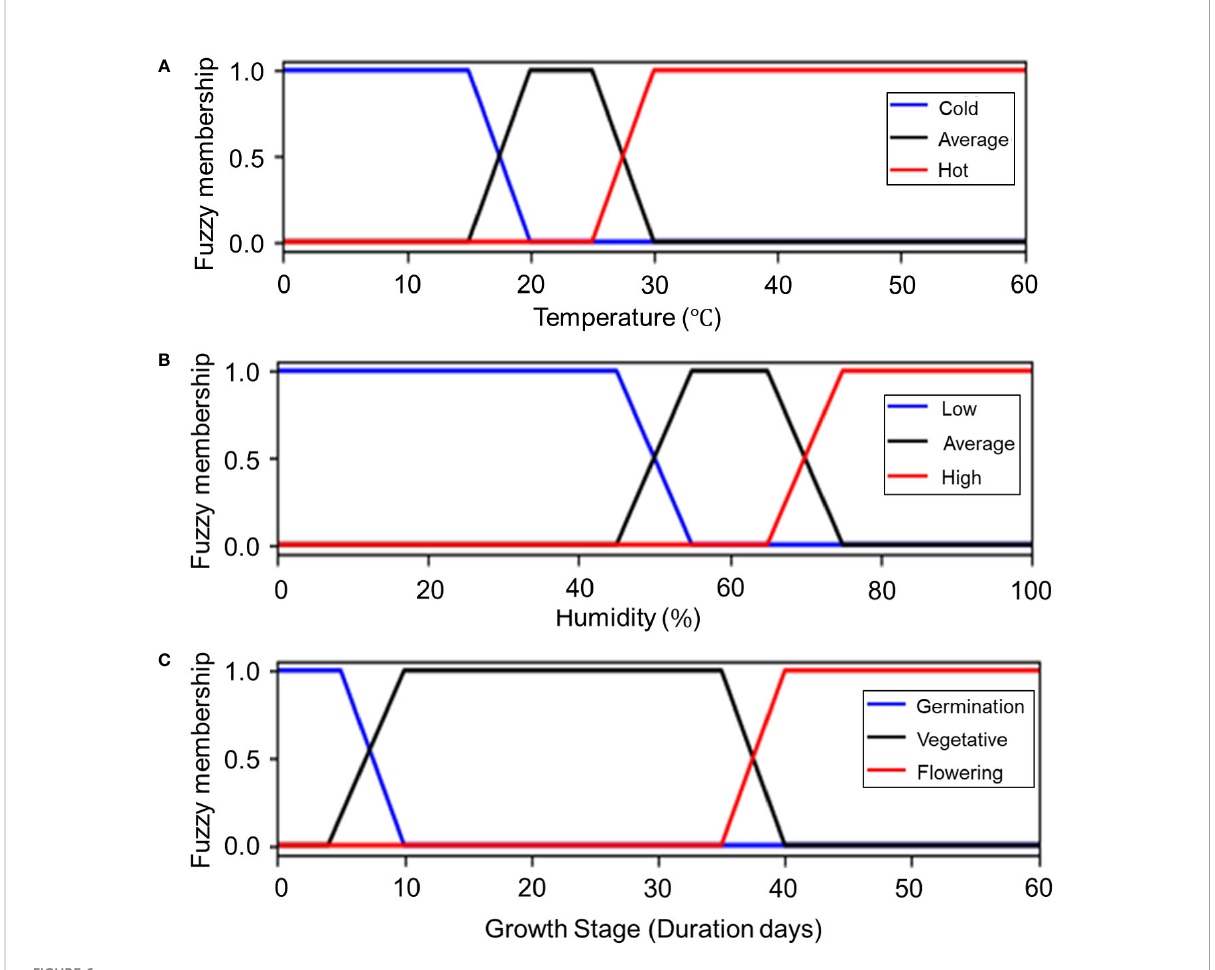
FIGURE 6 Membership functions of input variables. (A) Temperature, (B) humidity, and (C) growth